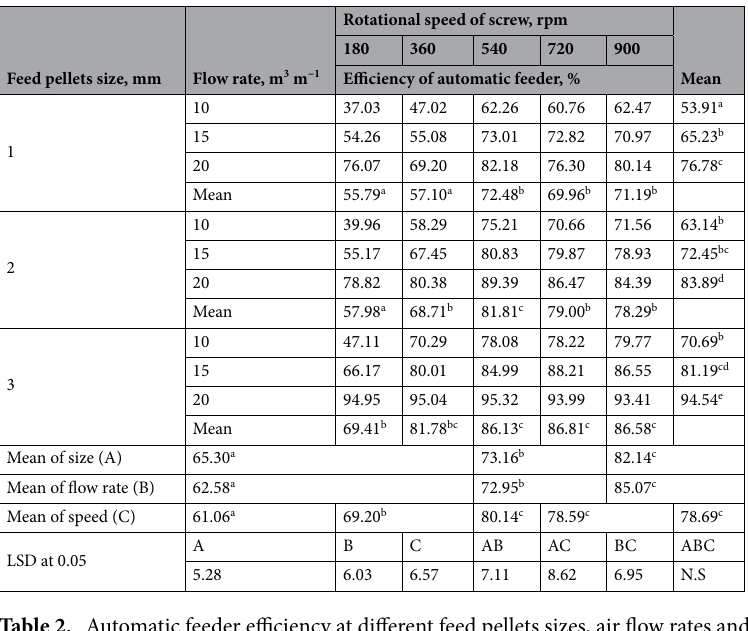
Table 2. Automatic feeder efficiency at different feed pellets sizes, air flow rates and rotational speeds of screw. Superscripts letters mean significantly between the treatments (statistical analysis).